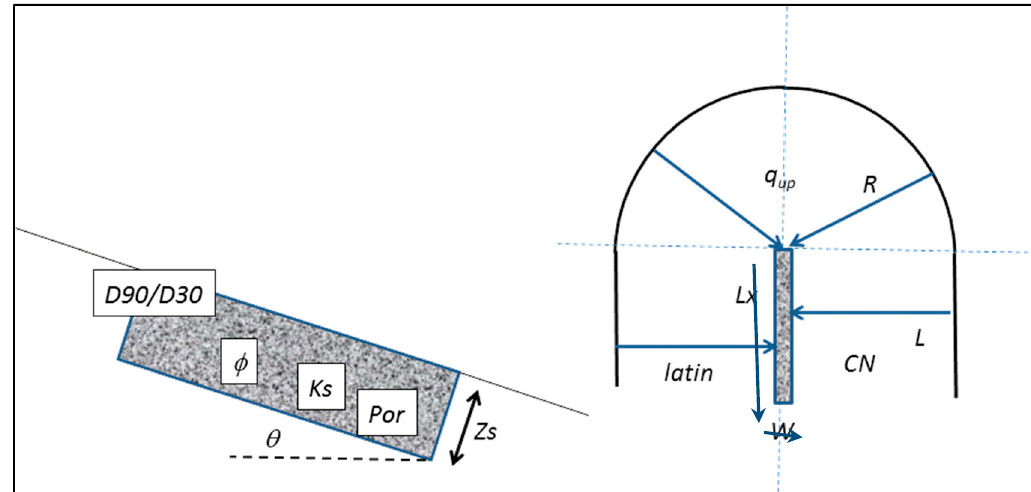
Figure 9. Morphometric and hydro-mechanical parameters, which were used for model simulations of debris flow initiation. For an explanation see Table 3 and text. D90/D30: 90% and 30% lower than grain size D90 and D30, respectively. φ : Friction angle; Ks : Hydraulic conductivity; Por : Porosity; Zs : Depth of material; θ : Slope angle; q up : Water that flows into the upper end of the channel bed; R : Radius of source area above the channel; Lx and W : Length and width of the channel bed; L : Length of lateral contributing slope; latin : Lateral inflow of water to the channel; CN : Curve number value for the soil hydrological and land use characteristics of the contributing slopes.